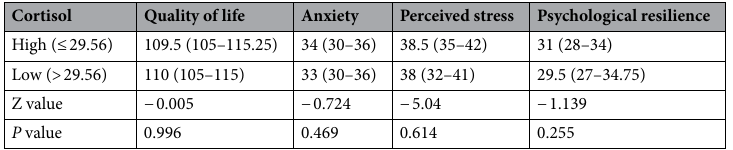
Table 3. Psychological stress by level of hair